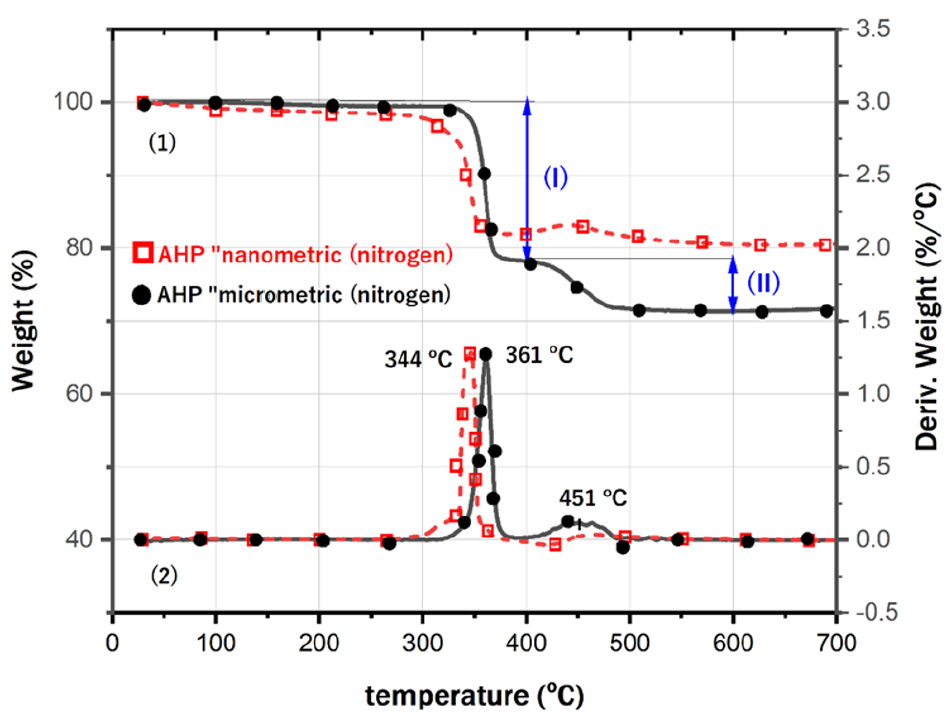
Figure 2. Comparative (1) TG and (2) DTG traces of AHP micro- and nanoparticles conditioned in N 2 atmosphere (heating rate: 20 °C/min). Table 1. TGA results obtained following the characterization of AHP (micro- and nanoparticles) under nitrogen and air.